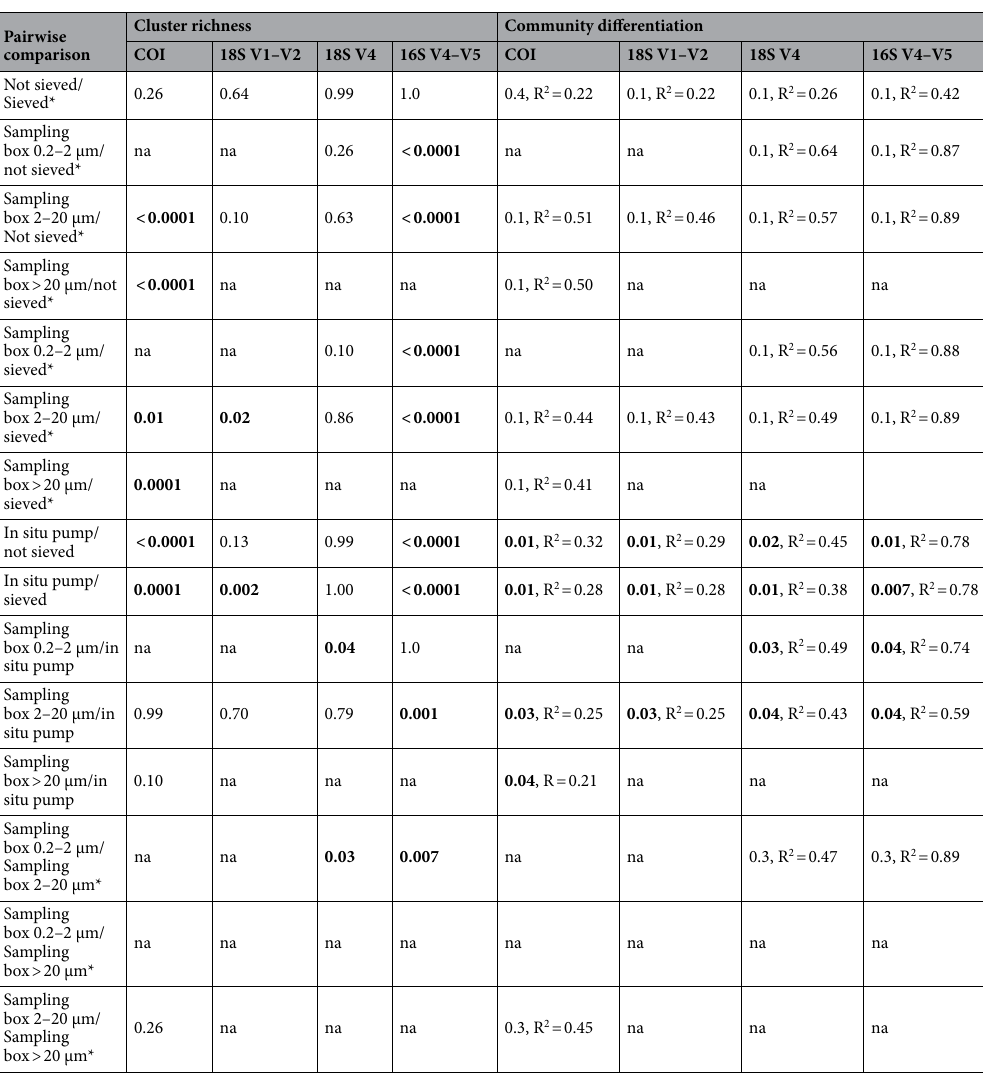
Table 1. Effect of sampling method on cluster richness and community structure for the 4 studied genes. Pairwise comparisons of ANOVAs of ASV/OTU richness performed using rarefied datasets. Pairwise PERMANOVAs were performed on rarefied datasets using Jaccard distances for metazoans and Bray–Curtis distances for 18S V4 and 16S V4–V5. Significance was evaluated by permuting 999 times when possible, and comparisons where this was not possible are marked by *. Significant p values are in bold. R 2 :